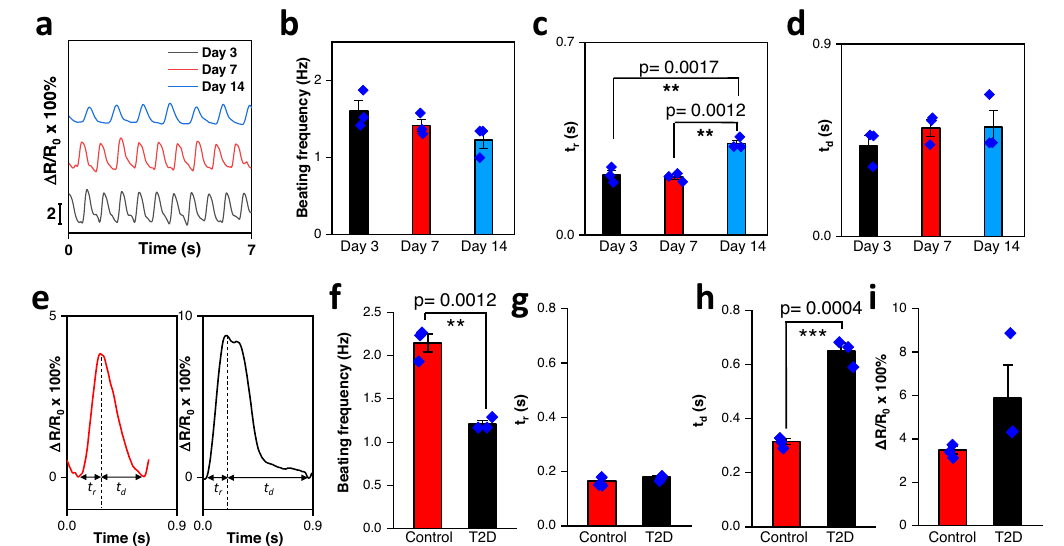
Fig. 5 | Developmental studies during tissue culture and diabetic disease modeling. a Representative contraction pro fi les showing changes in resistance ratioofthesensorinduced bythecontractionandrelaxationofanorganoid atday 3, 7, and 14. b – d Beating frequency ( b ), rise time ( c ), and decay time ( d ) of orga- noids at day 3, 7, and 14 obtained from sensor output ( n =3). e Representative waveformpatternsoforganoidsincontrolgroup(left)anddiabeticgroup(right)at